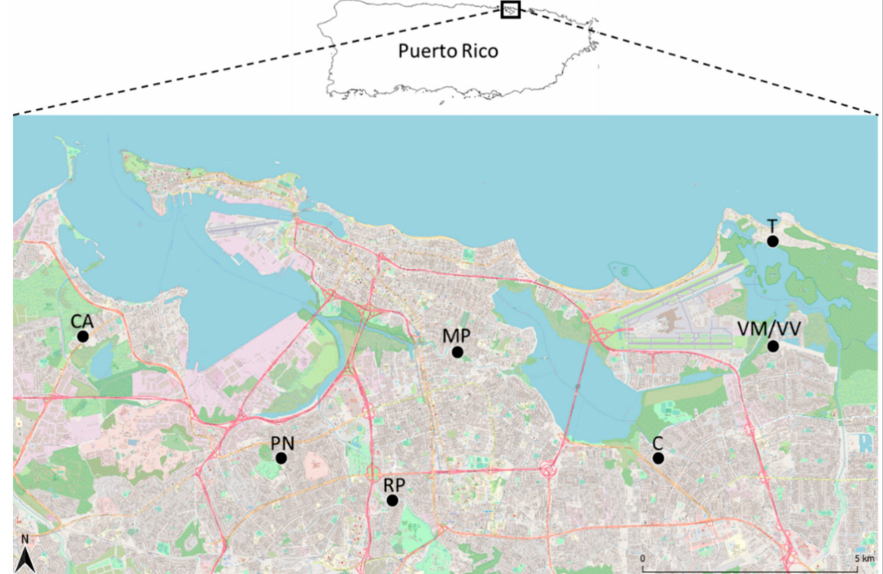
Figure 1. Map of mosquito-trapping locations in the San Juan Metropolitan Area, Puerto Rico in 2018 and 2019. The inset highlights the location of San Juan on the island of Puerto Rico. Each of the black dots represent the centroid of latitude and longitude of all traps deployed in the